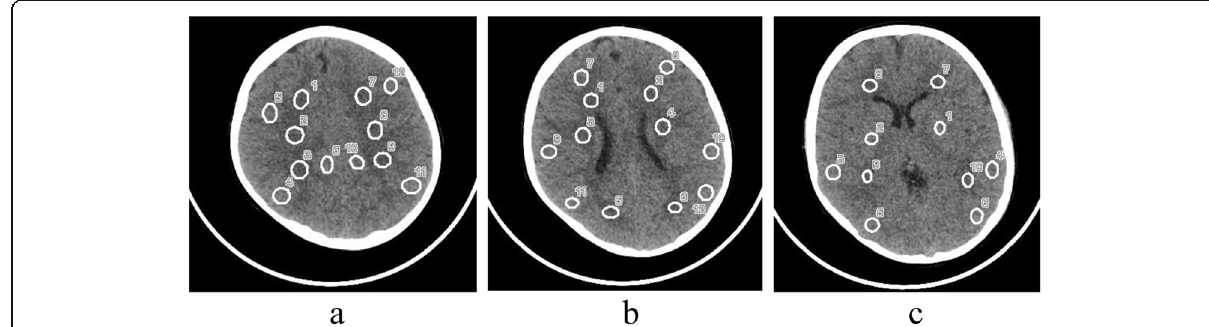
Fig. 2 Sites of chosen gray matter and white matter ROIs for calculation of SNR and CNR. a Sites of gray matter ROIs (4 – 6, 10 – 12)and white matter ROIs (1 – 3, 7 – 9) at the level of centrum semiovale. b Sites of gray matter ROIs (1 – 6) and white matter ROIs (7 – 12) at level of corona radiata. c Sites of gray matter ROIs (1 – 6) and white matter ROIs (7 – 10) at level of thalamus